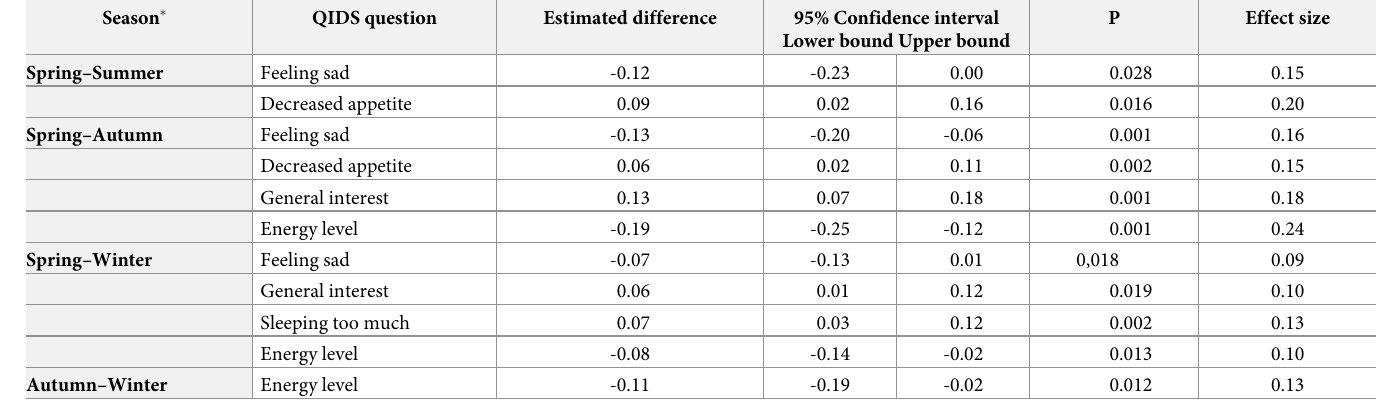
Table 5. Post hoc tests; estimated mean differences between the seasons in eight separate questions of the